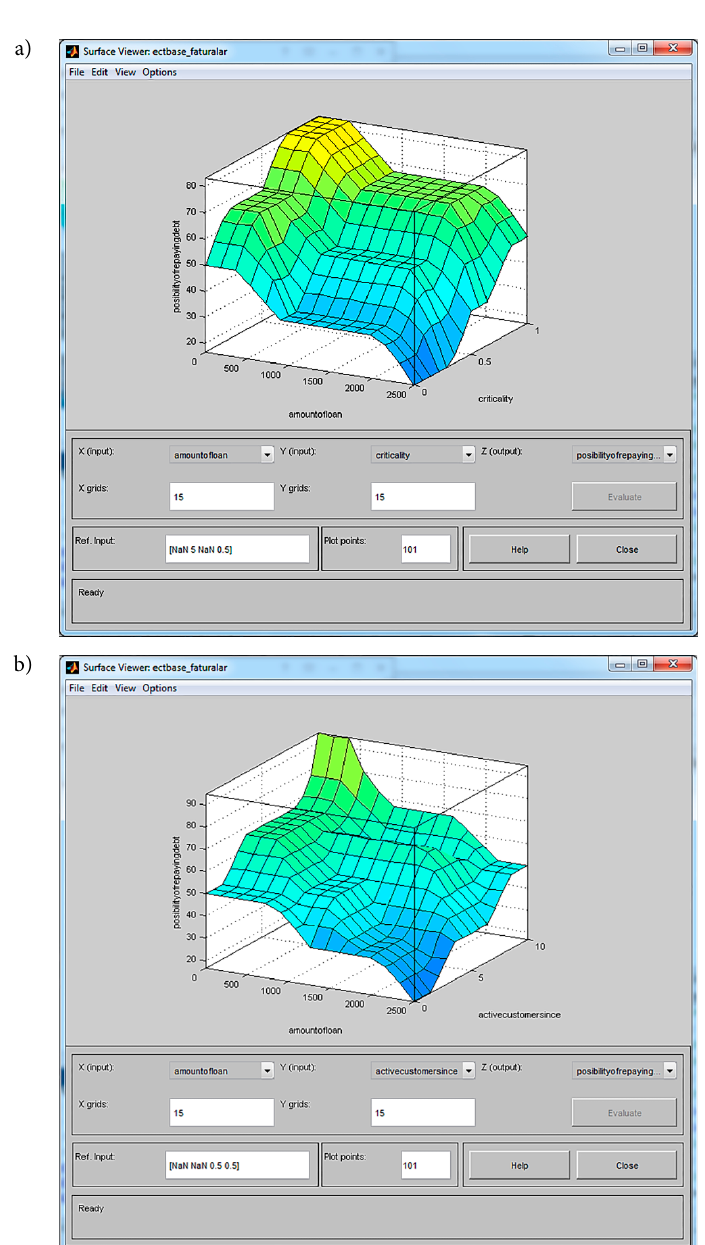
Figure 9. Three dimensional rules for invoice